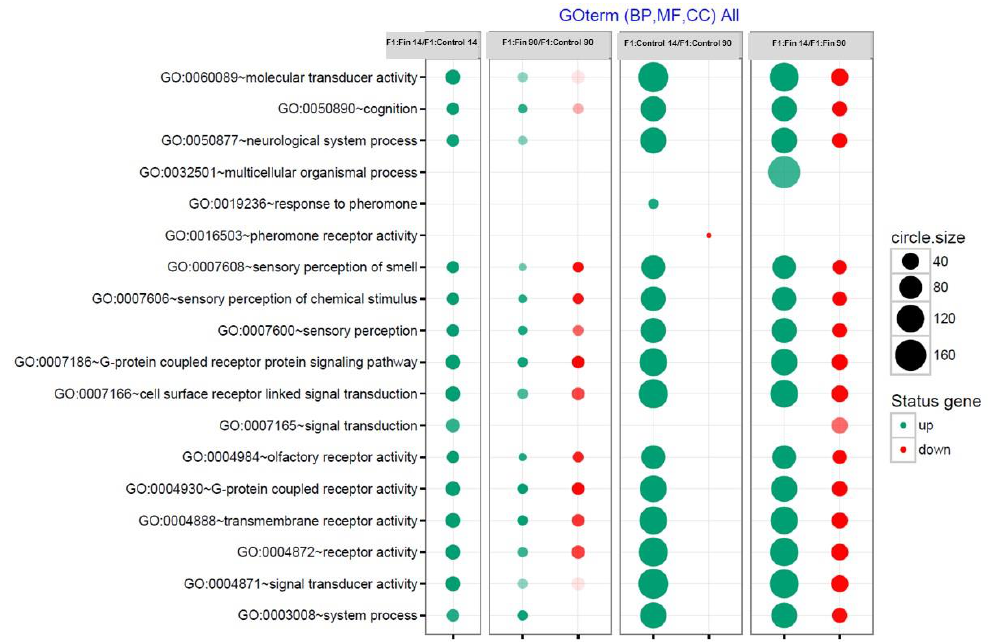
Figure 3. Biological process, molecular function, and cellular component assigned according to the Gene Ontology (GO) classification for DEGs found in homogenates of testicular tissue from four groups of experimental rats; the comparisons were made in F1:Fin or F1:Control group in relation to age (F1:Control 14/F1:Control 90; F1:Fin 14/F1:Fin 90) or between experimental and control group in relation to their age (F1:Fin 14/F1:Control 14; F1:Fin 90/F1:Control 90). Groups of genes fulfilling the criteria: adjusted p < 0.05, method = Benjamini, and minimum number of genes per group = 5, are presented in a graph in which the bubble size indicates the number of genes represented in the corresponding annotation and the condition of these genes in terms of their up- and down-regulation. The transparency of the bubbles reflects the p -value (more transparent is closer to the border of p = 0.05).